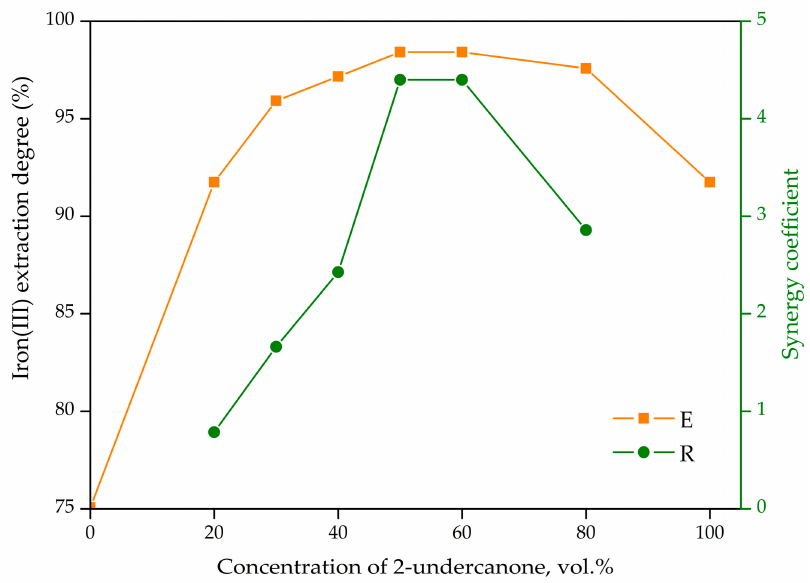
Figure 3. The dependence of iron(III) extraction degree (E) and synergy coefficient (R) on the concentration of 2-undercanone at C(HCl) = 5.7 M, C(Fe) = 8.4 g/L, O:A = 1:1.